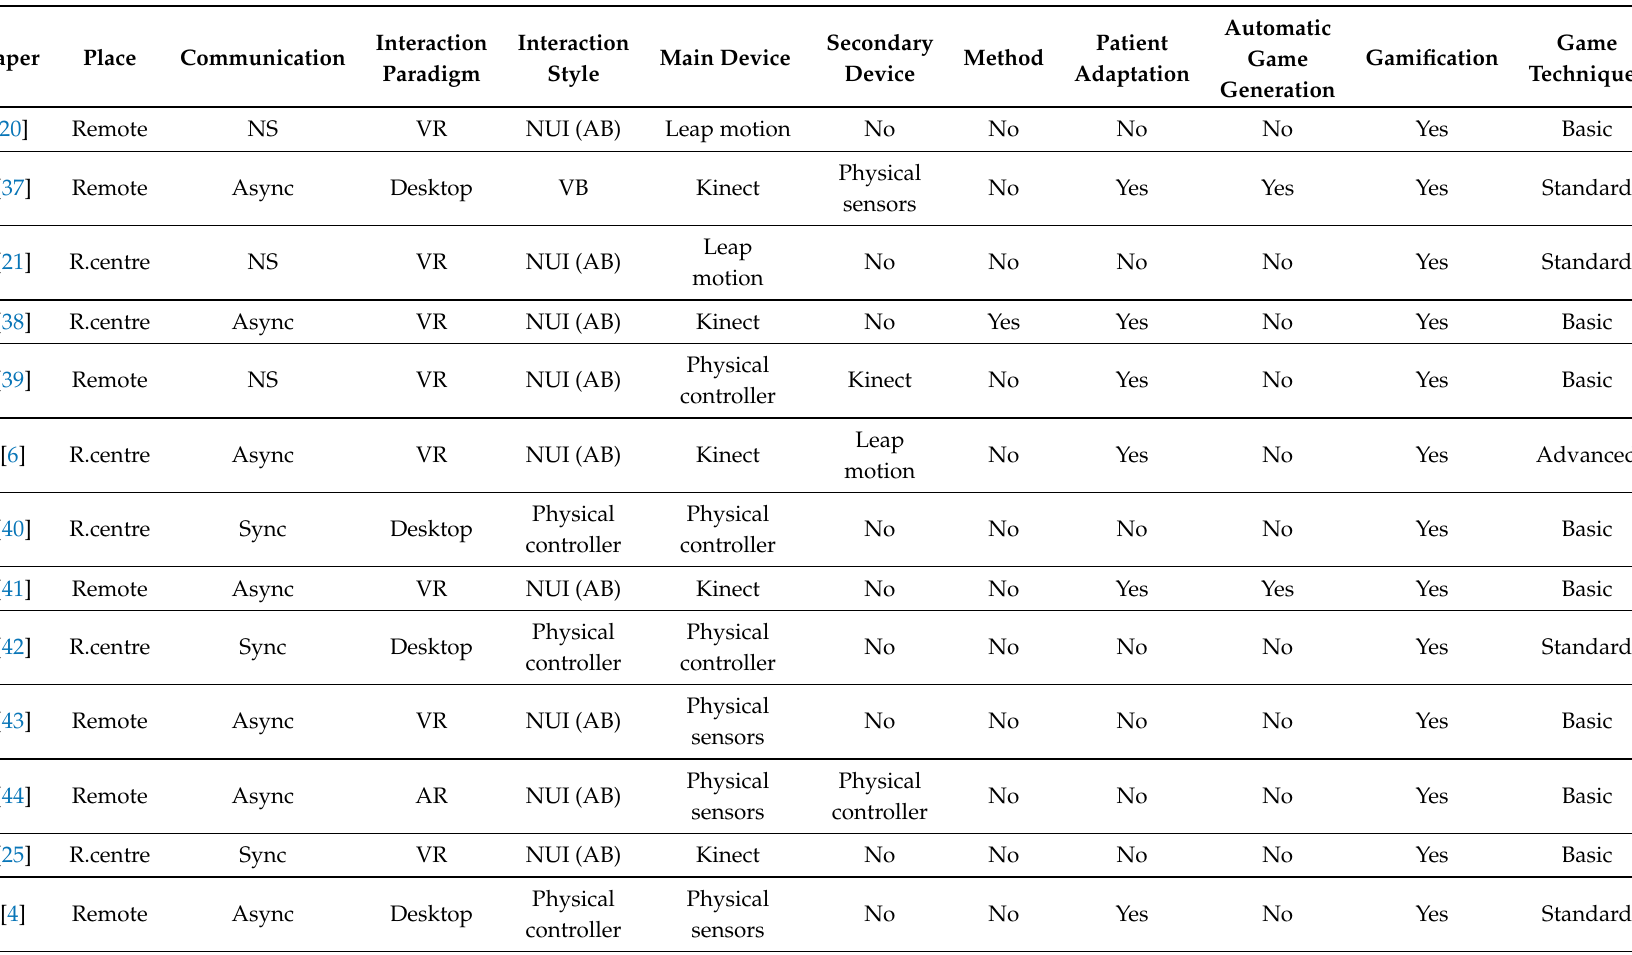
Table 5. Characteristics of rehab systems; R.centre: Rehab centre, NS: No specified, VR: Virtual Reality, AR: Augmented Reality, NUI: Natural User Interface, AB: Air-based, VB: Voice-Based, Indep.: Independent.